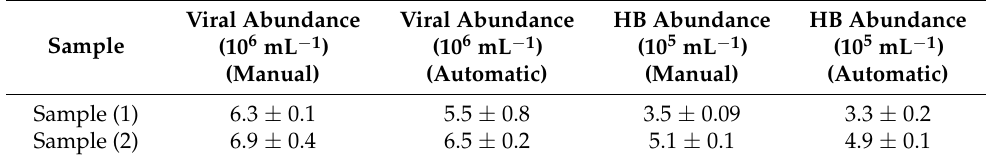
Table 1. Comparison of the viral and heterotrophic bacterial (HB) abundances (mean ± SE) obtained using manual or automated sampling. There were not significantly differences between methods ( t -test, p > 0.05) 1